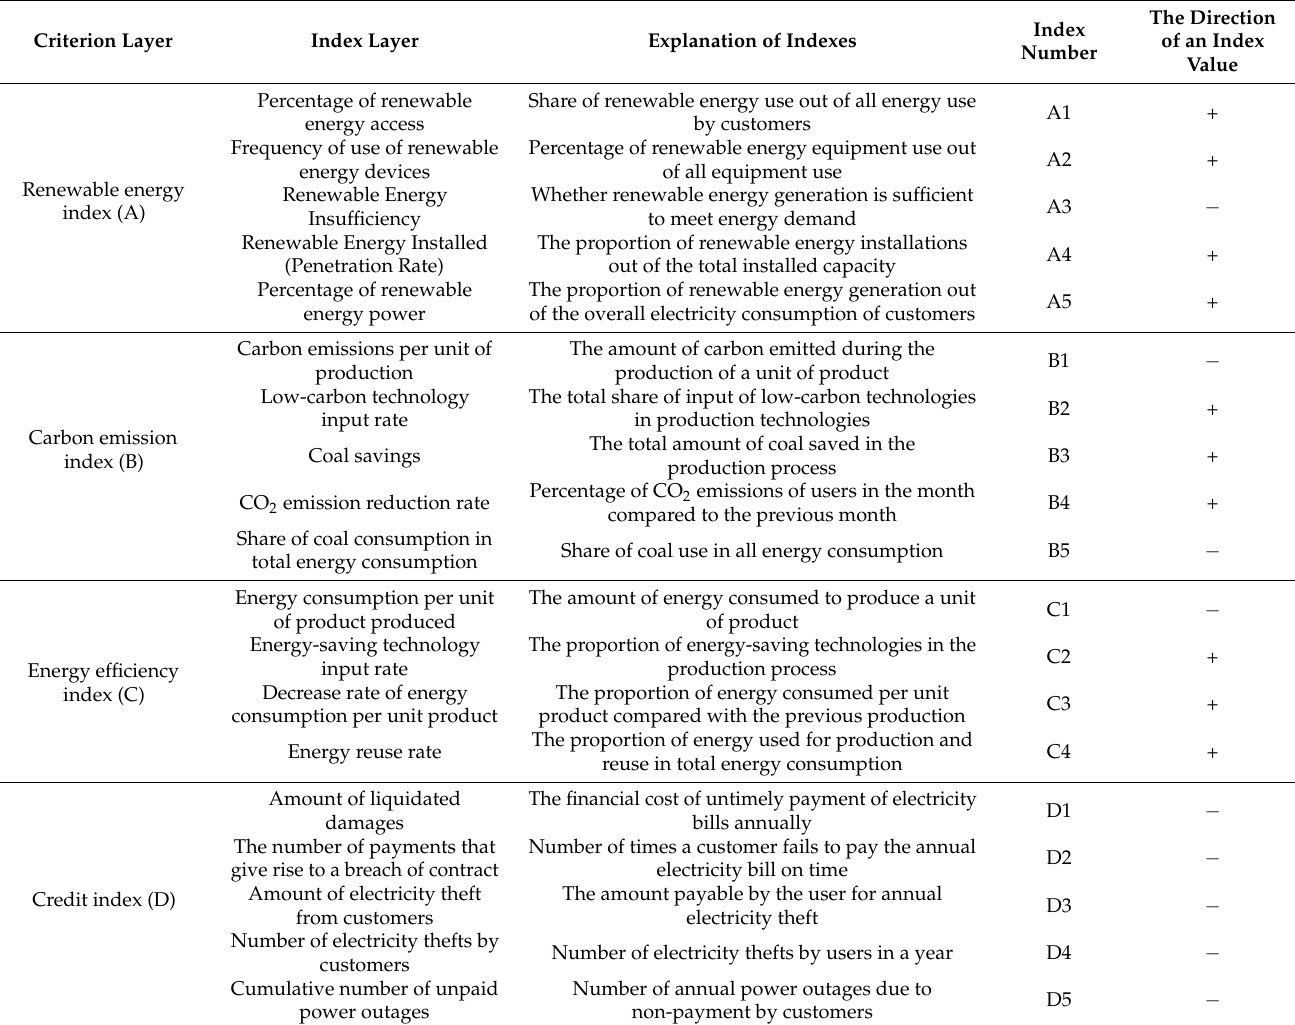
Table 1. Comprehensive evaluation index system of user lean